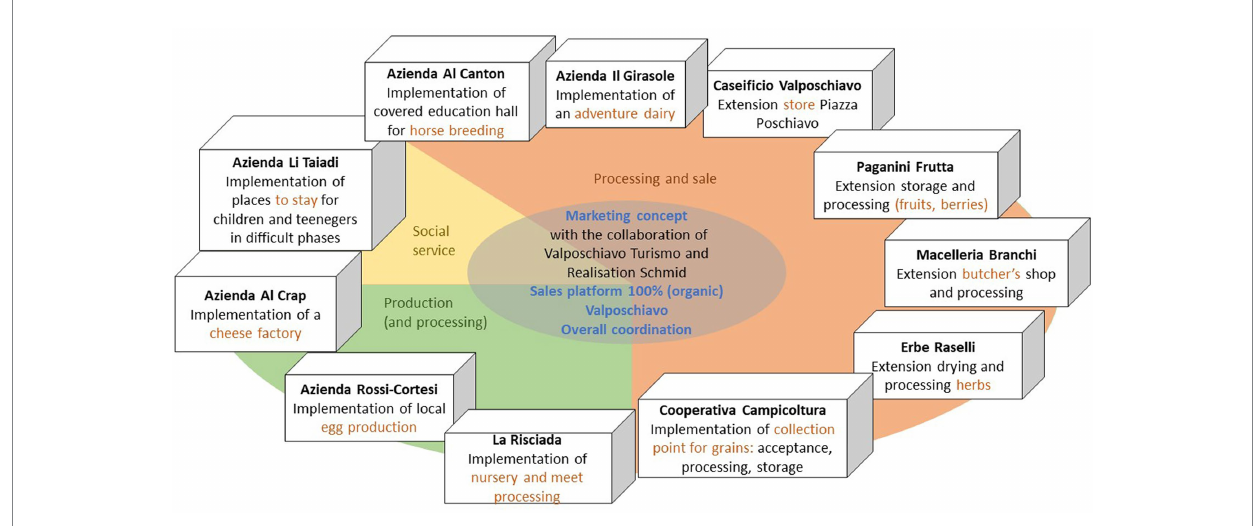
FIGURE 4 Structure and participating actors of the PRE 100% (bio) Valposchiavo, Source: Pola (2020), created by the